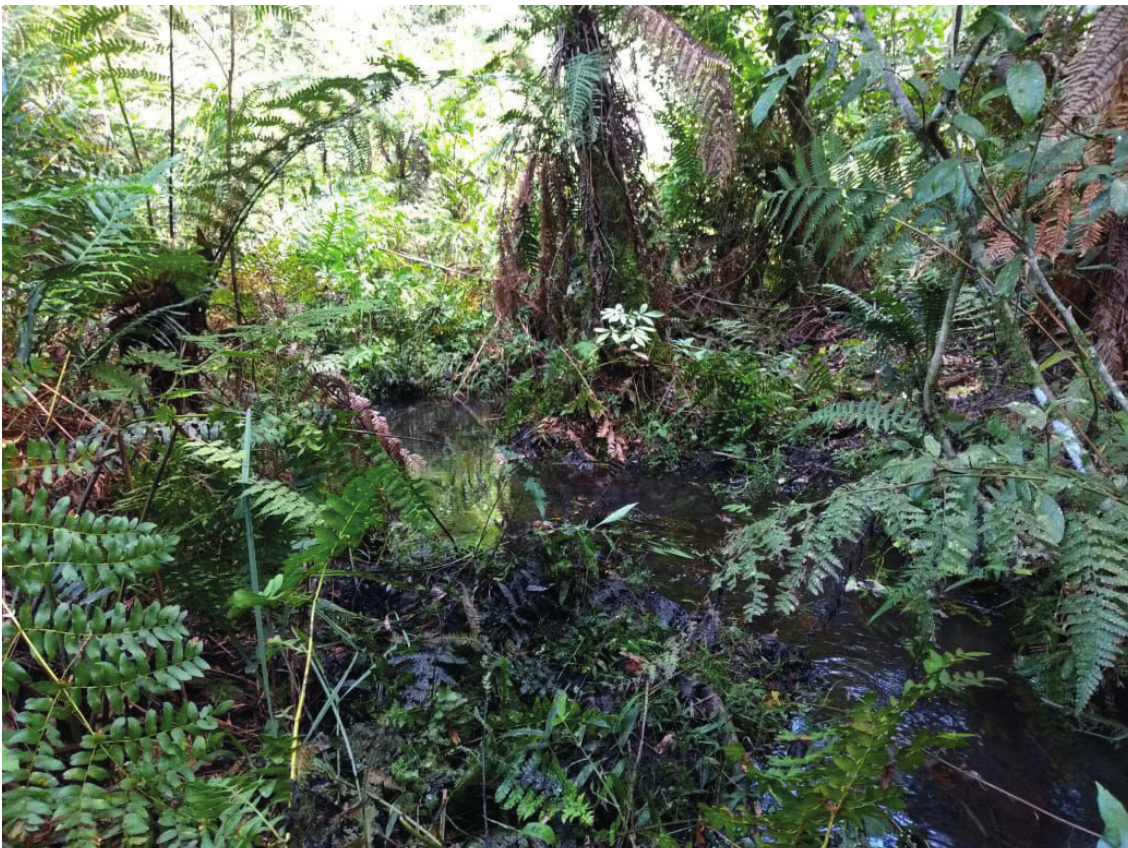
Fig. 4. Type locality of Cambeva alphabelardense sp.